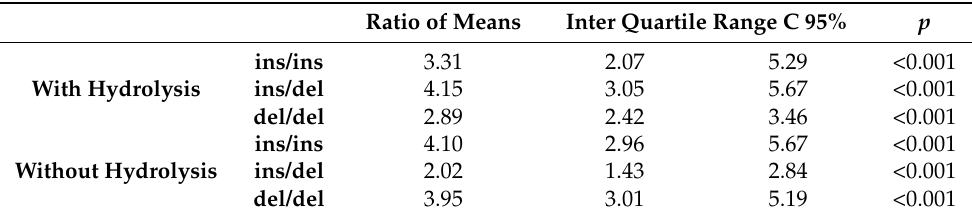
Table 3. Androgenic activity in urine of athletes measured by AR CALUX ® with and without hydrolysis for each of the three different types of genotypes expressed as the values of the ratio of means between period C1 and C2 (pre and post T adm.), the inter quartile range, and the p value. Ratio of